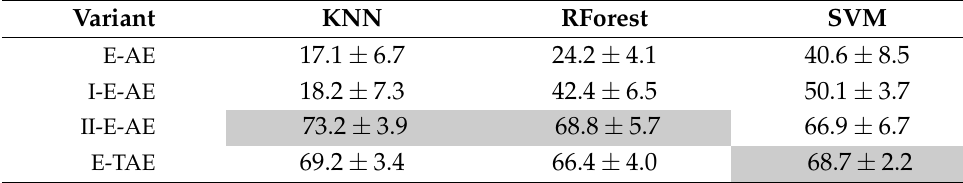
Table 4. For each of the 10 experimental runs per method after 250 epochs and using the VGG-11 extractor, we trained different classifiers in the latent space: k-nearest neighbour (KNN), random forest (RForest) and support vector machine with a linear kernel (SVM). We either used the triplet loss (TAE), the first (I) or the second variation (II) of the PIRL and the extractor module (E). Most of the contribution to the synthetic to real generalization on TICaM is due to the II variation of the PIRL cost